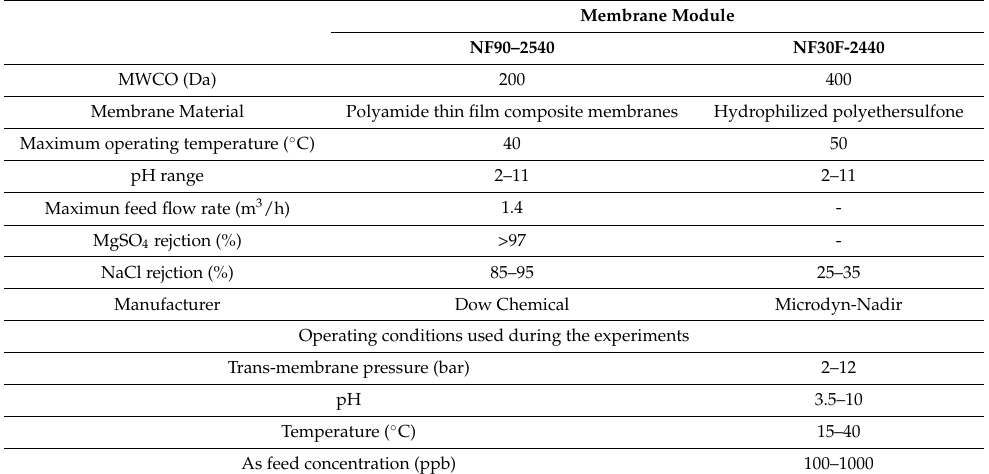
Table 8. Characteristics of the membrane modules. Adapted with permission from ref. [63]. Copy- right 2021